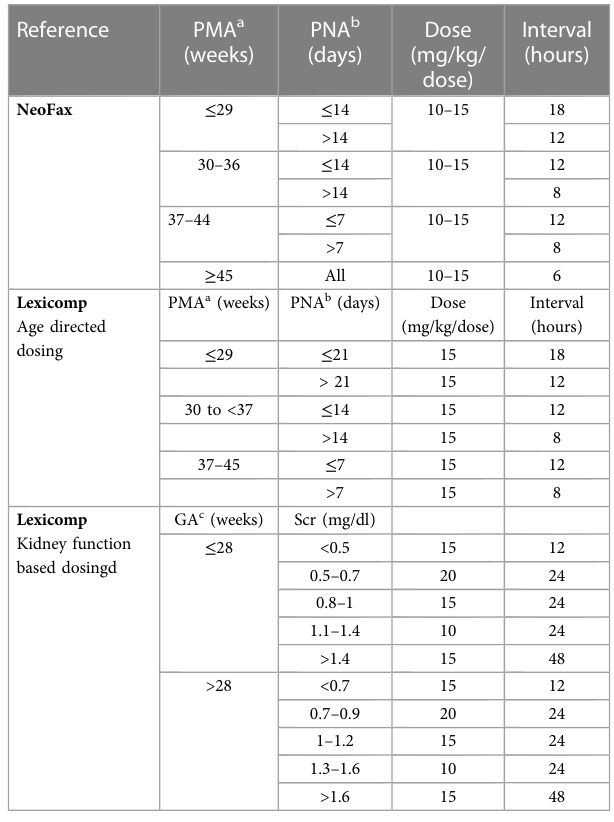
TABLE 1 Vancomycin dosing regimens from neonatal dosing references commonly used in participating